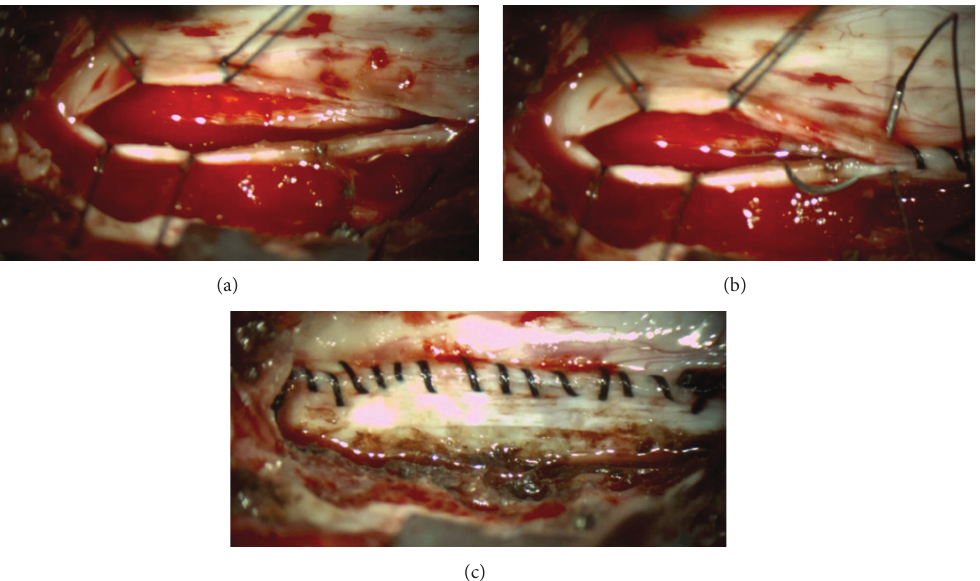
Figure 3: (a) View of the durotomy before dural closure. (b) Continuous, running midline closure of the dura was performed using a CV-20 needle with 4-0 Surgilon braided nylon. (c) Completion of dura closure.